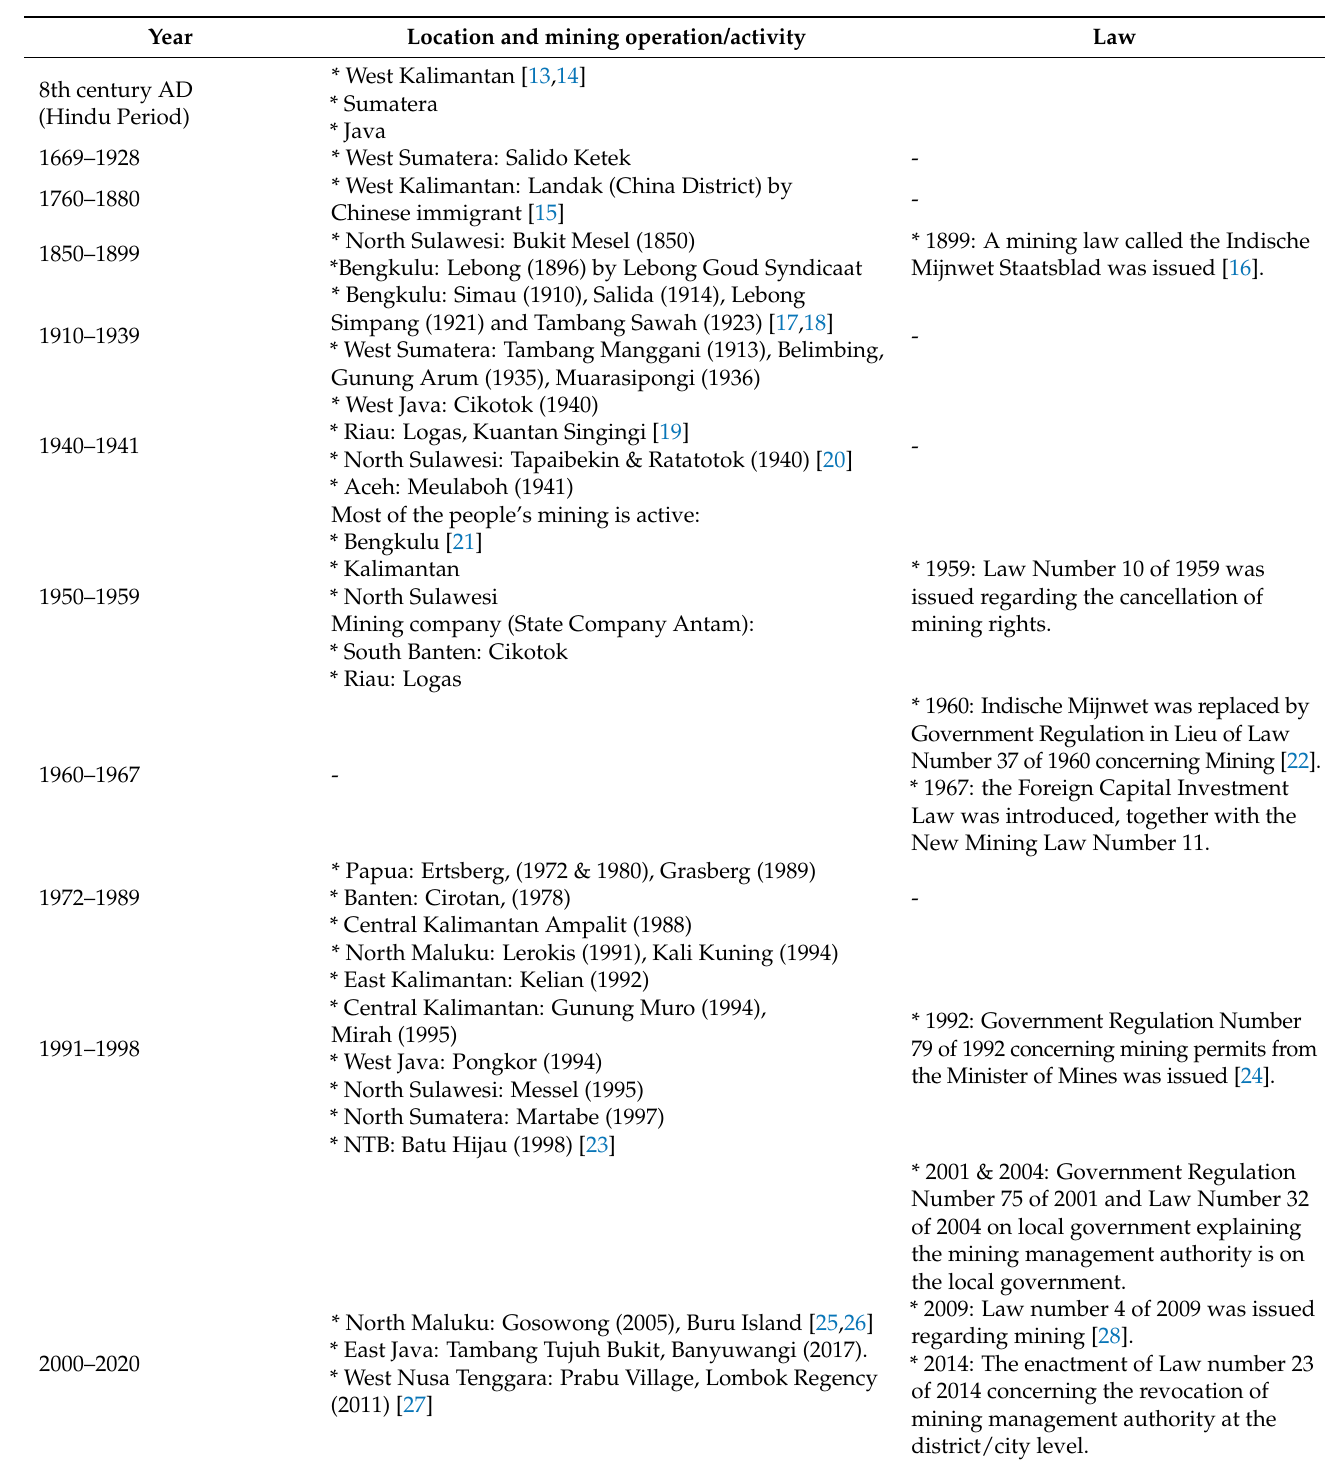
Table 1. History of Active Mining and Law in